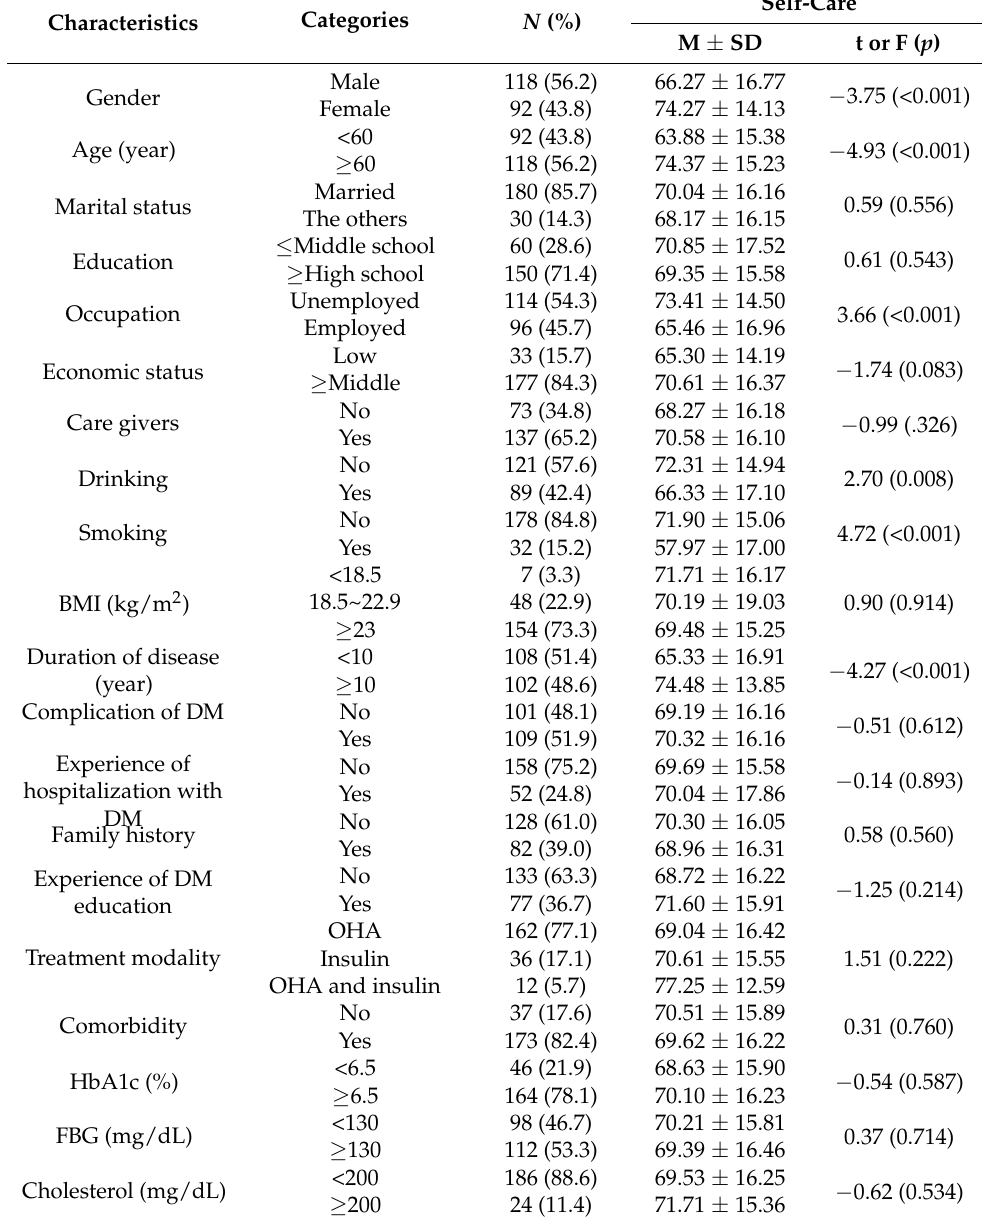
Table 1. Participants Characteristics and Difference in Self-Care According to Participants’ Character- istics ( N =